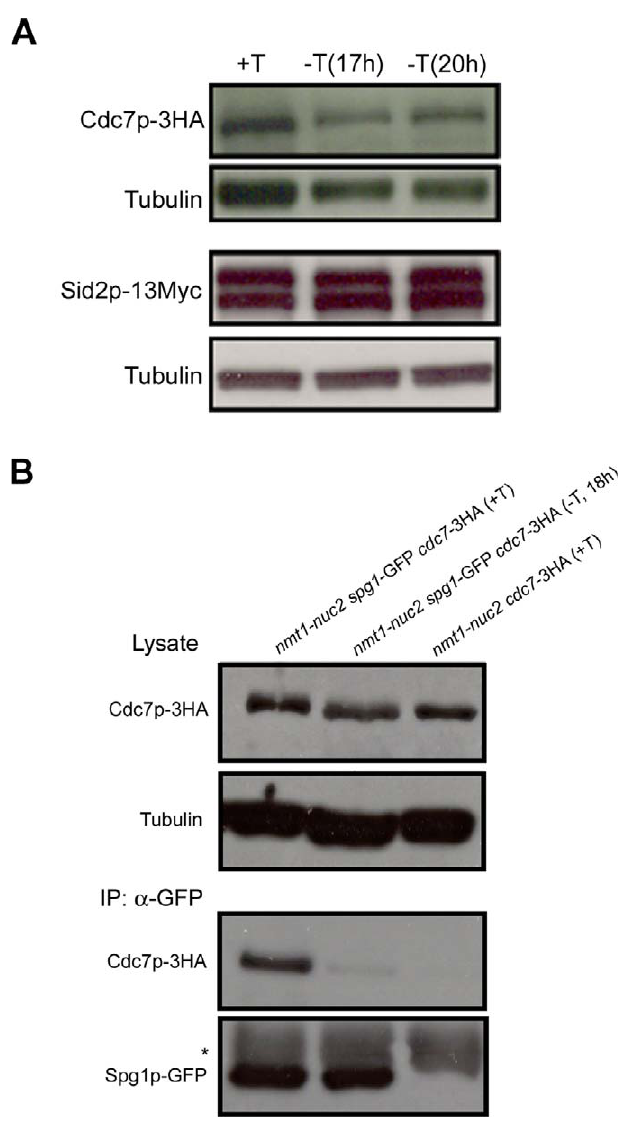
Figure 5. Overexpression of Nuc2p Does Not Affect the Steady-State Levels of Cdc7p-3HA and Sid2p-13Myc, but Disrupts the Binding of Spg1p-GFP and Cdc7p-3HA (A) Protein levels of Cdc7p-3HA and Sid2p-13Myc in nmt1-nuc2 cells grown in medium with or without thiamine. Tubulin serves as the loading control. (B) Lysates from cells expressing Cdc7p-3HA and Spg1p-GFP in the presence or absence of Nuc2p overexpression were immunoprecipitated with GFP antibodies and immunoblotted with antibodies against the HA epitope. Lysates from a strain without Spg1p-GFP was included as the control. Tubulin serves as the loading control. Asterisk indicates heavy chain of